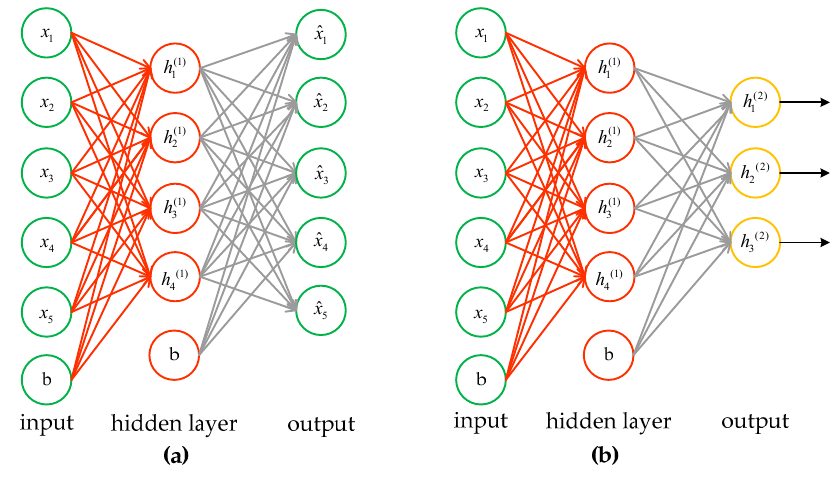
Figure 5. The structure of autoencoder and SAE. ( a ) A three-layers autoencoder; ( b ) A SAE composed of two autoencoders.